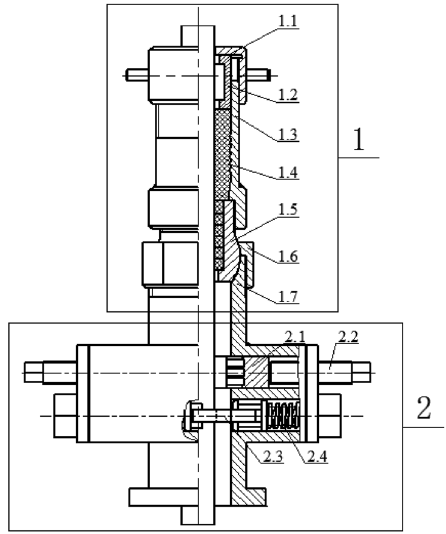
Fig. 4 Offshore composite wellhead equipment ( 1 -packing center- adjustable wellhead structure: 1.1 -packing press cap, 1.2 -packing press shell, 1.3 -packing box, 1.4 -packing, 1.5 -ball-end, 1.6 -ball-end press cap, 1.7 -ball-end pedestal; 2 -rod broken automatic shut-in and manual sealing wellhead structure: 2.1 -sealing ontology, 2.2